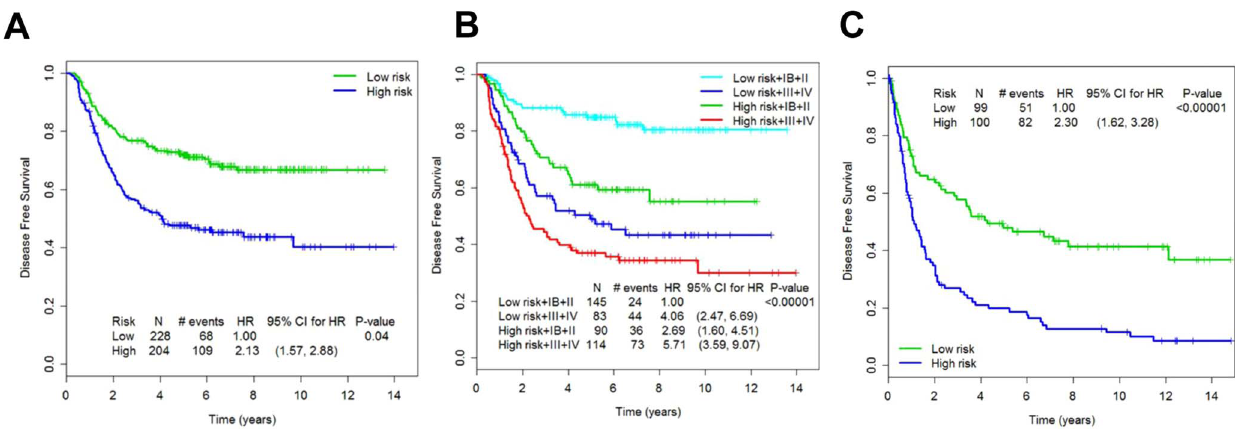
Figure 2. Kaplan-Meier curves for high risk and low risk groups classified by leave one out cross validation procedure. HR denotes hazard ratio and p-value is calculated from 100 permutations. (A) all stage patients, high vs low risk; (B) according to stage and risk groups; (C) External validation of the initial gene expression profiling.